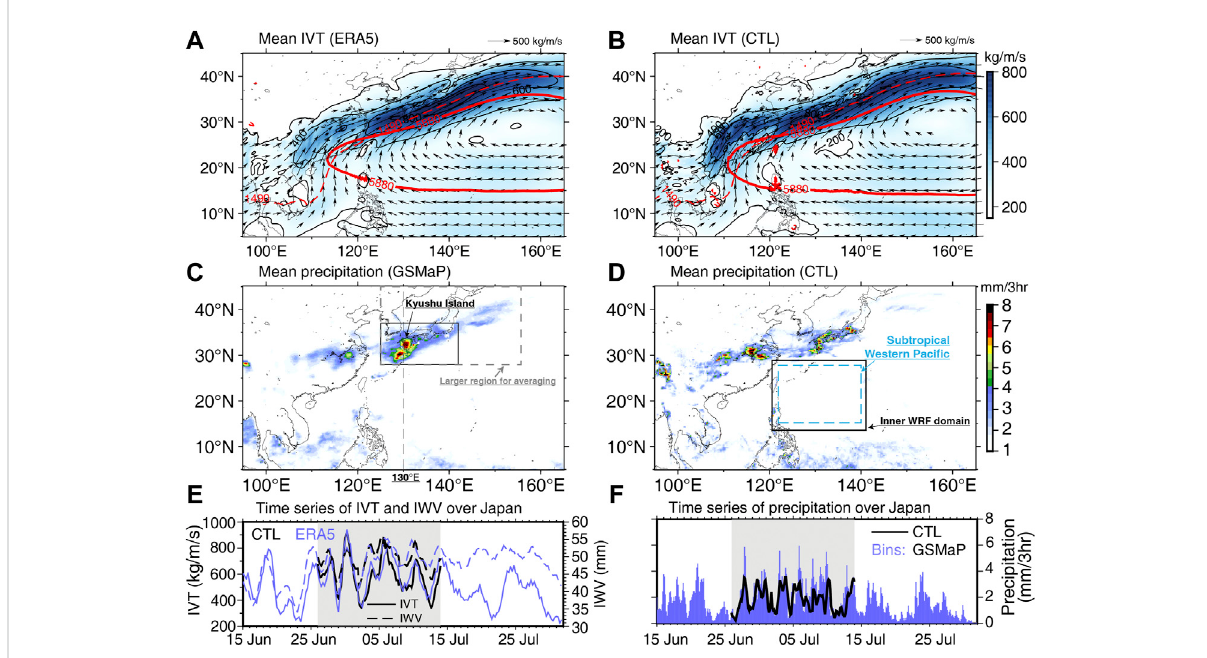
FIGURE 1 (A,B) Mean moisture transport (IVT by color and contours with every 200 kg/m/s, and moisture fl uxes by vectors) together with the 1490-gpm and5880-gpmgeopotentialheight(redcontours)and (C,D) meanprecipitationduringtheperiodfrom26Juneto13July[grayshadingin (E,F) ].